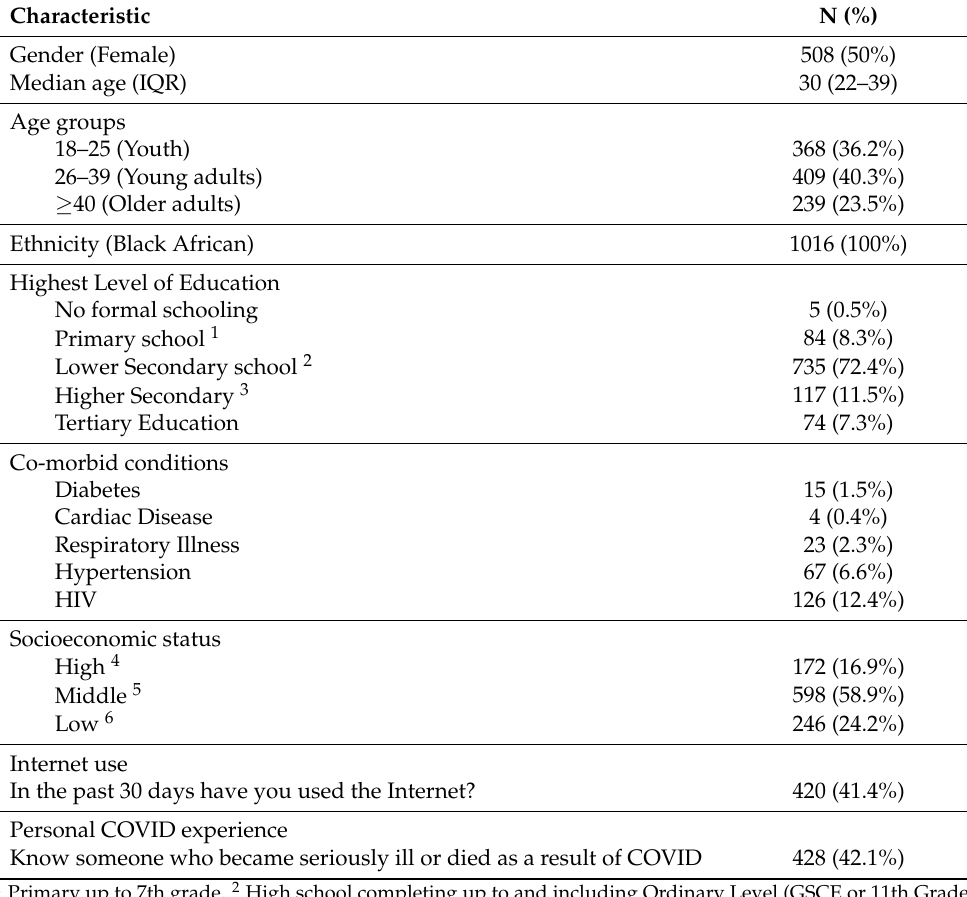
Table 1. Baseline cohort